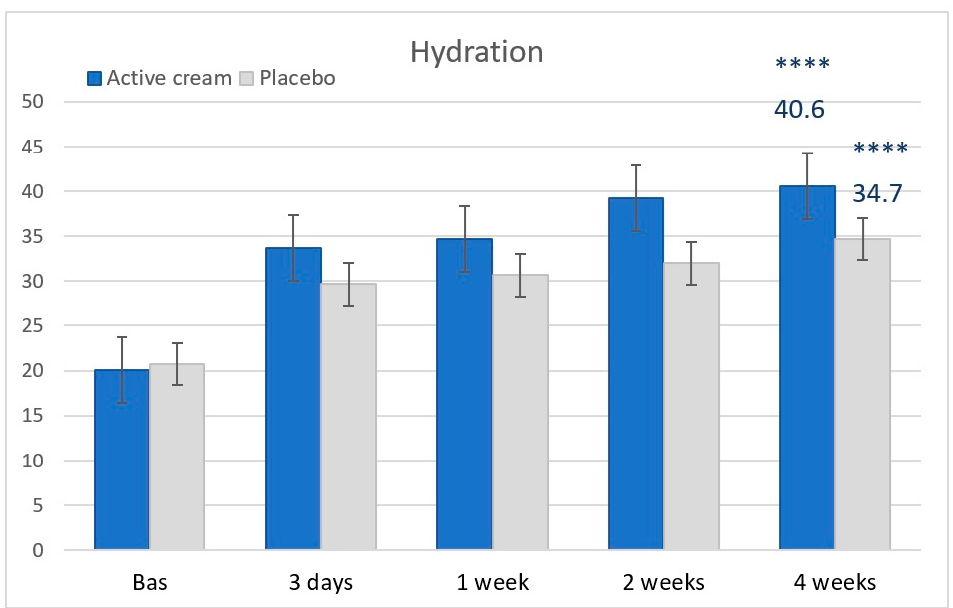
Figure 3. Hydration values (mean + SD) show an increase of + 102% in the hydrogel with 2% of ceramides and trehalose based ingredient) site after 4 weeks (**** p < 0.01 ( t -test) ; n = 15 subjects; Bas = Baseline, T0; 4 weeks = after 4 weeks of